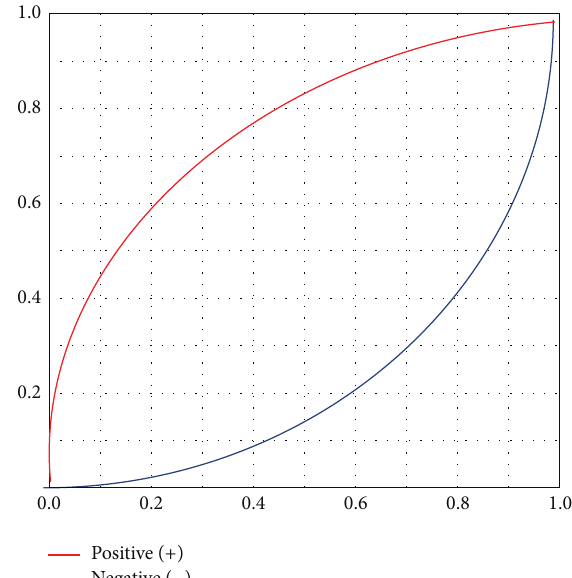
Figure 2: Posttest probability graph for the ADA cut-off value of 6 IU/L in